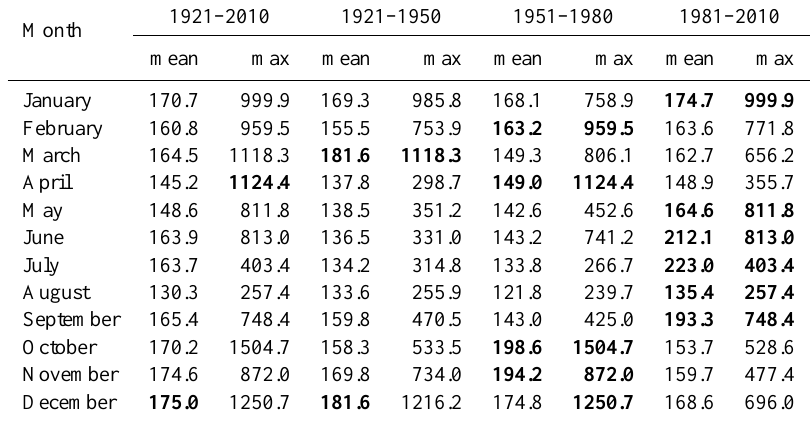
Table 2. Average (mean) and maximum (max) values of cumulated event rainfall E (in mm) for rainfall events in the 90-year period 1921– 2010, and in three 30-year periods. The largest monthly values in each period are shown in bold.